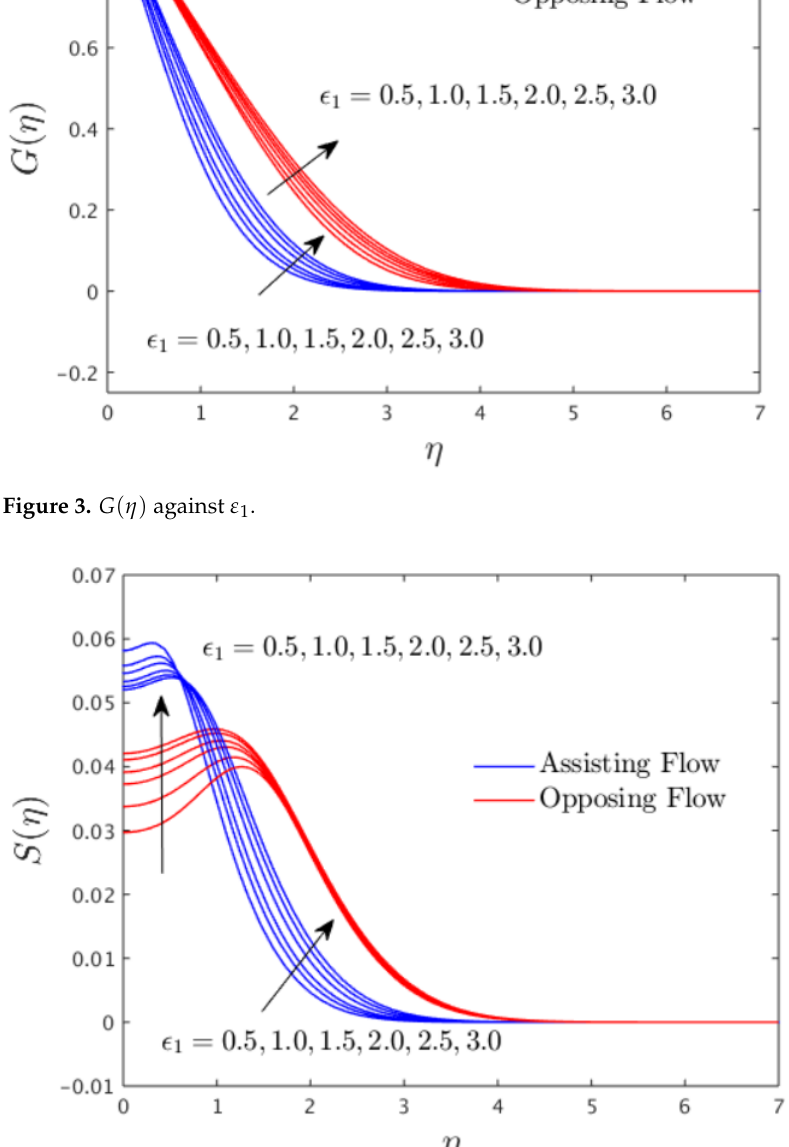
Figure 4.   S  against 1 